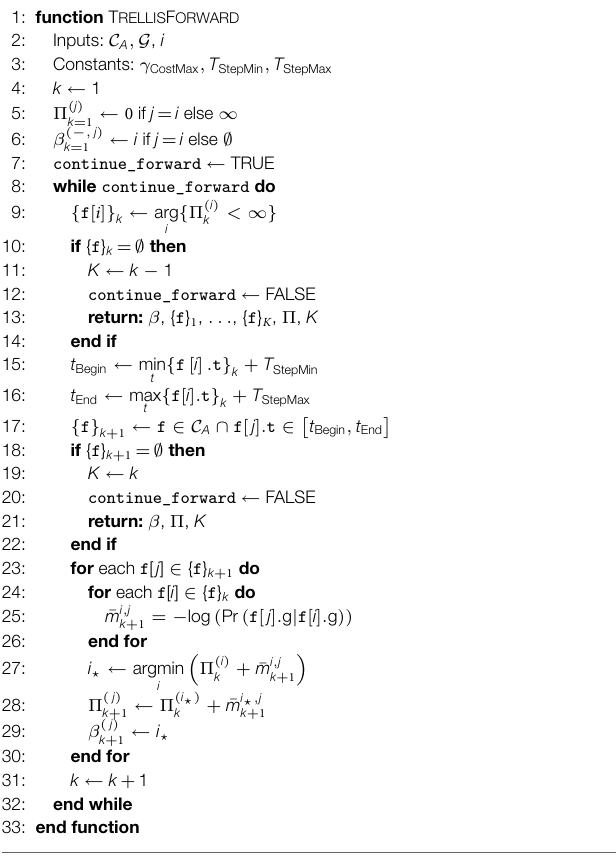
ALGORITHM 2 | Calculate Footstep Trellis in Forward Phase.